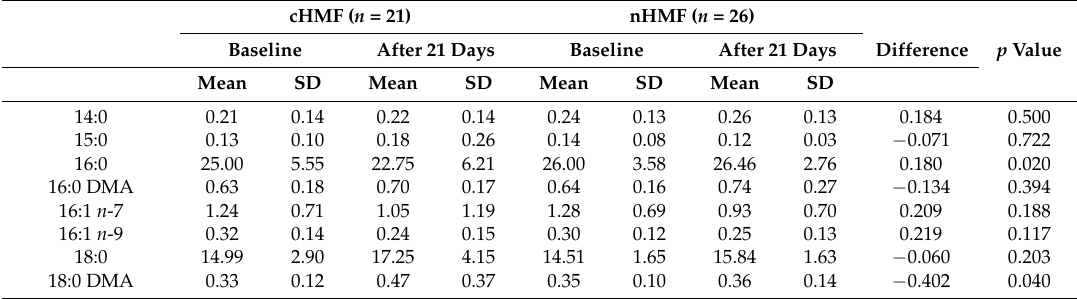
Table 4. (Corrected) Fatty acid profile (g/100 g of fatty acids) of total plasma phospholipids in preterm infants, receiving human milk fortified with a control (cHMF) or with a new human milk fortifier (nHMF) before and after 21 days of treatment. Estimates of the treatment effect nHMF/cHMF (difference) and the two-sided p -values are given for each fatty acid analyzed in the different lipid